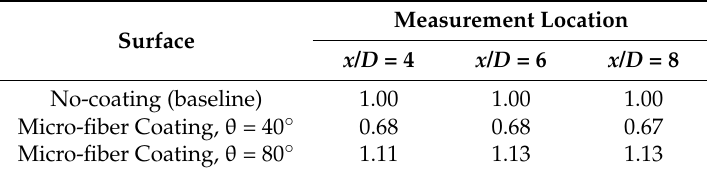
Table 1. Normalized drag coefficients, c d-norm , at the downstream